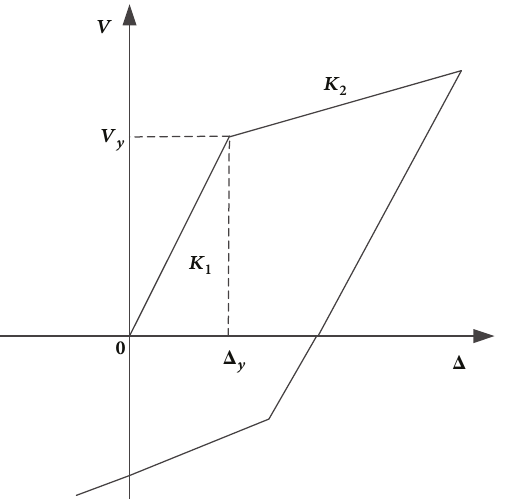
Figure 3: Bilinear restoring force model for each lateral load-resist- ing member. Figure 4: Variation of b